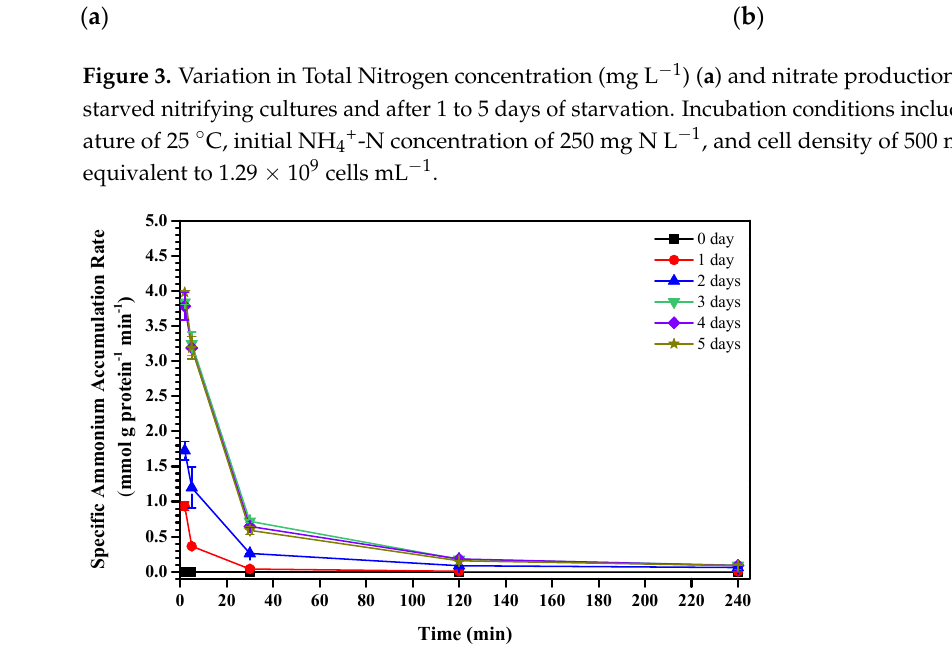
Figure 4. Effect of starvation period on the Specific Ammonium Accumulation Rate (mmol g protein − 1 min − 1 ) upon inoculation in 250 mg N L − 1 . Incubation conditions included temperature of 25 °C, initial NH 4+ -N concentration of 250 mg N L − 1 , and cell density of 500 mg TSS L − 1 , equivalent to 1.29 × 10 9 cells mL − 1 .